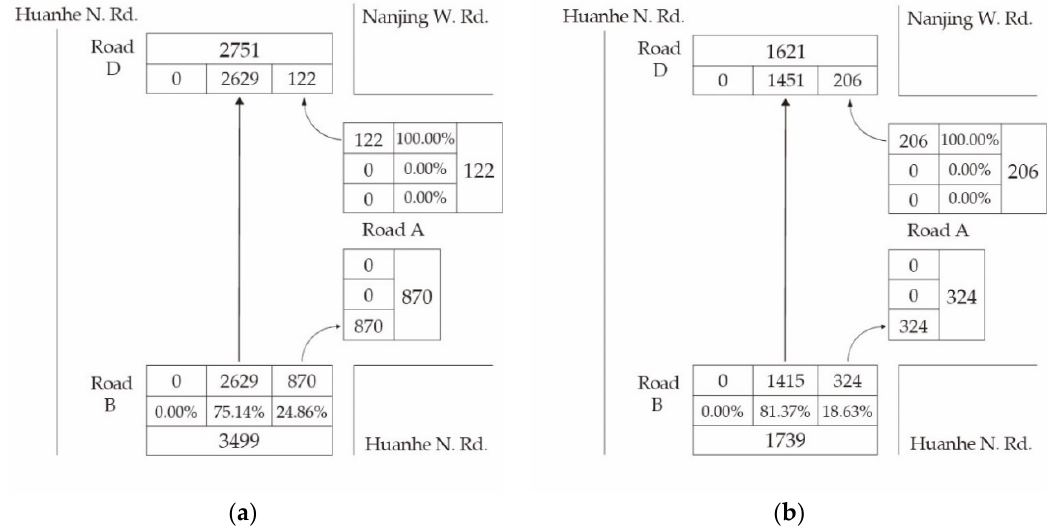
Figure 6. Road traffic data of Huanhe N. Rd and Nanjing W. Rd. ( a ) 8:00 a.m. to 9:00 a.m. ( b ) 5:00 p.m. to 6:00 p.m.